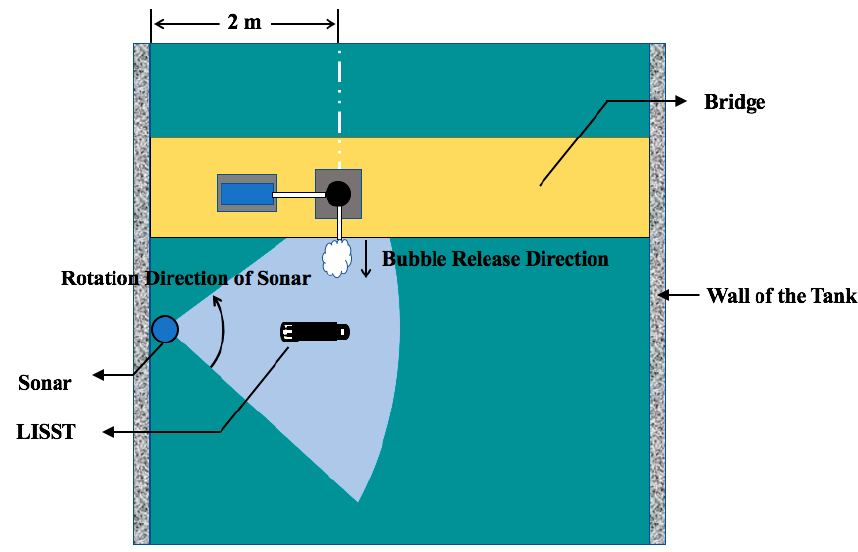
Figure 6. Top view of the setup of the sonar and LISST-200X in the tow tank. Table 2. The number of test and corresponding positions of sonar and LISST-200X. Test No.